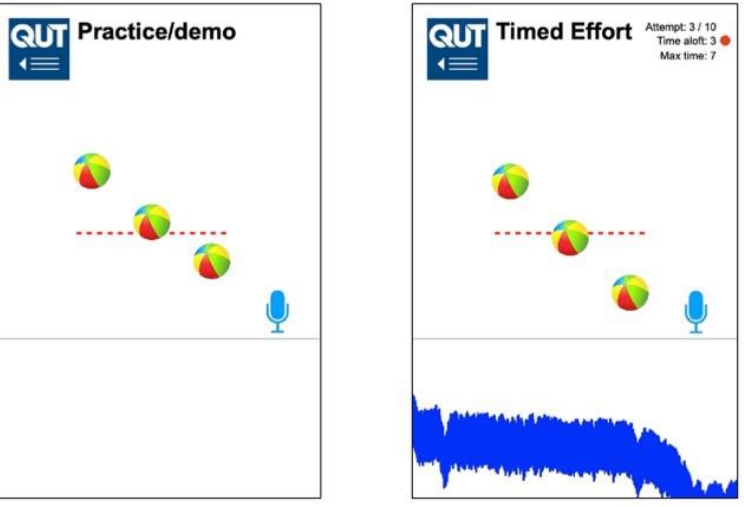
Figure 2. QUT Inspire incentive spirometer application—practice and timed modes.